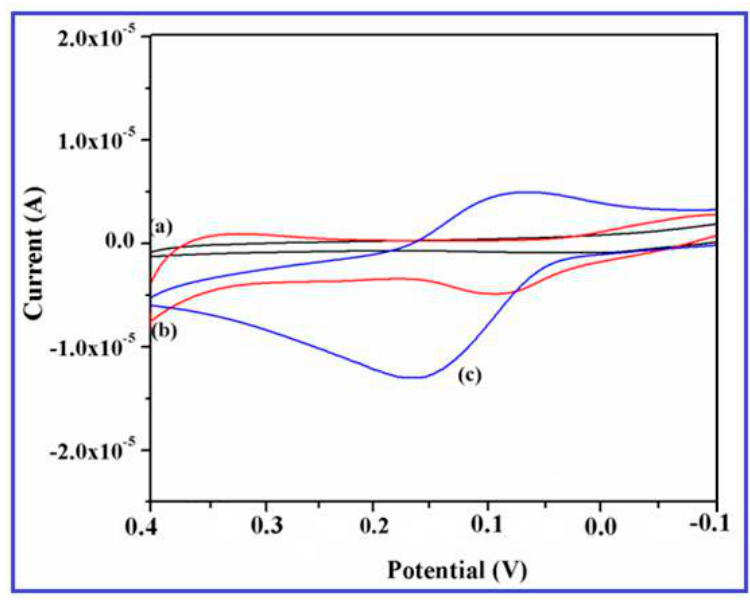
Figure 7. Cyclic voltammograms of ( a ) unmodified glassy carbon electrode (GCE), ( b ) CuO nanowires/GCE in PBS (pH 7.4), and ( c ) CuO nanowire/GCE at 0.2 mM DA dissolved in 0.1 M phosphate buffer (pH 7.4) solution recorded at a scan rate 50 mV/s.